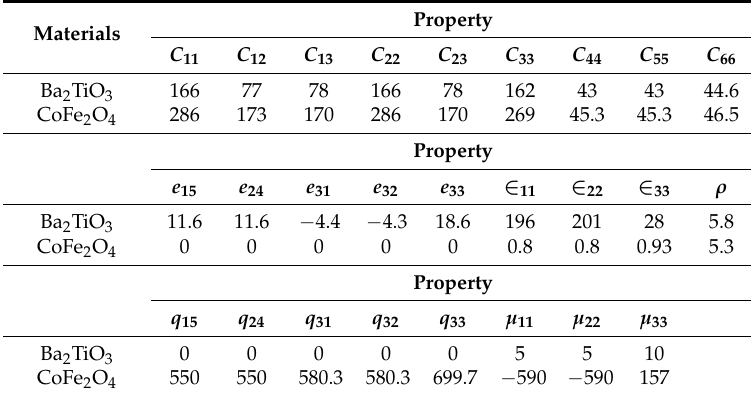
Table 1. Material parameters of two piezoelectric-piezomagnetic materials.